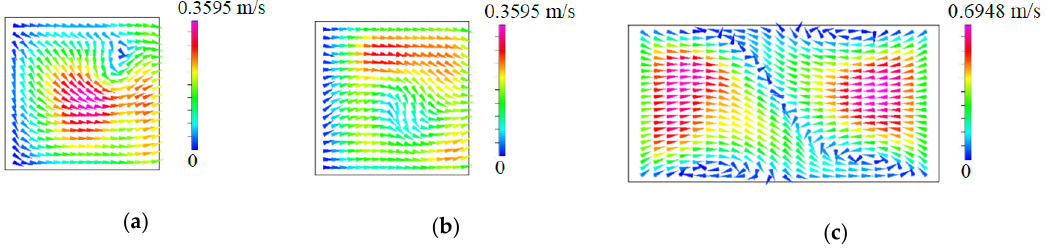
Figure7. yz -projectionofthevelocityvectorsonthecross-sectionsat( a ) x = H ,( b ) x = − H ,( c ) xz -projection of the velocity vectors on the cross-sections at y = H for the case with Re = 140 , θ s = 20 ◦ , h = 0.75 H , t = 0.25 H and w d = 0.25 H .